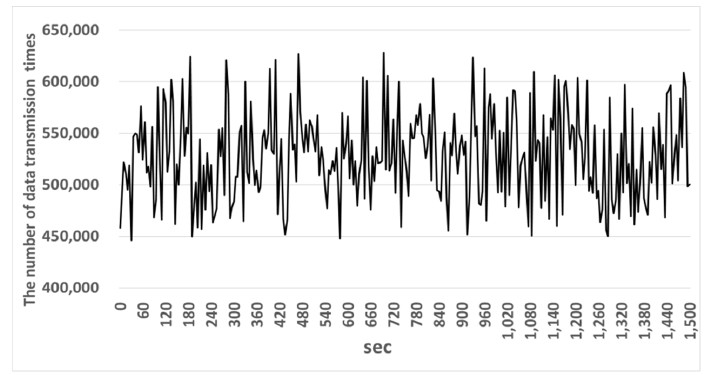
Figure 15. Data transmission quantity in the OFSG.